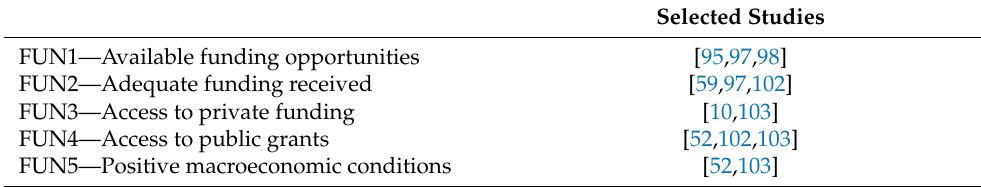
Table 5. Construction of the funding and finance factor from the literature.